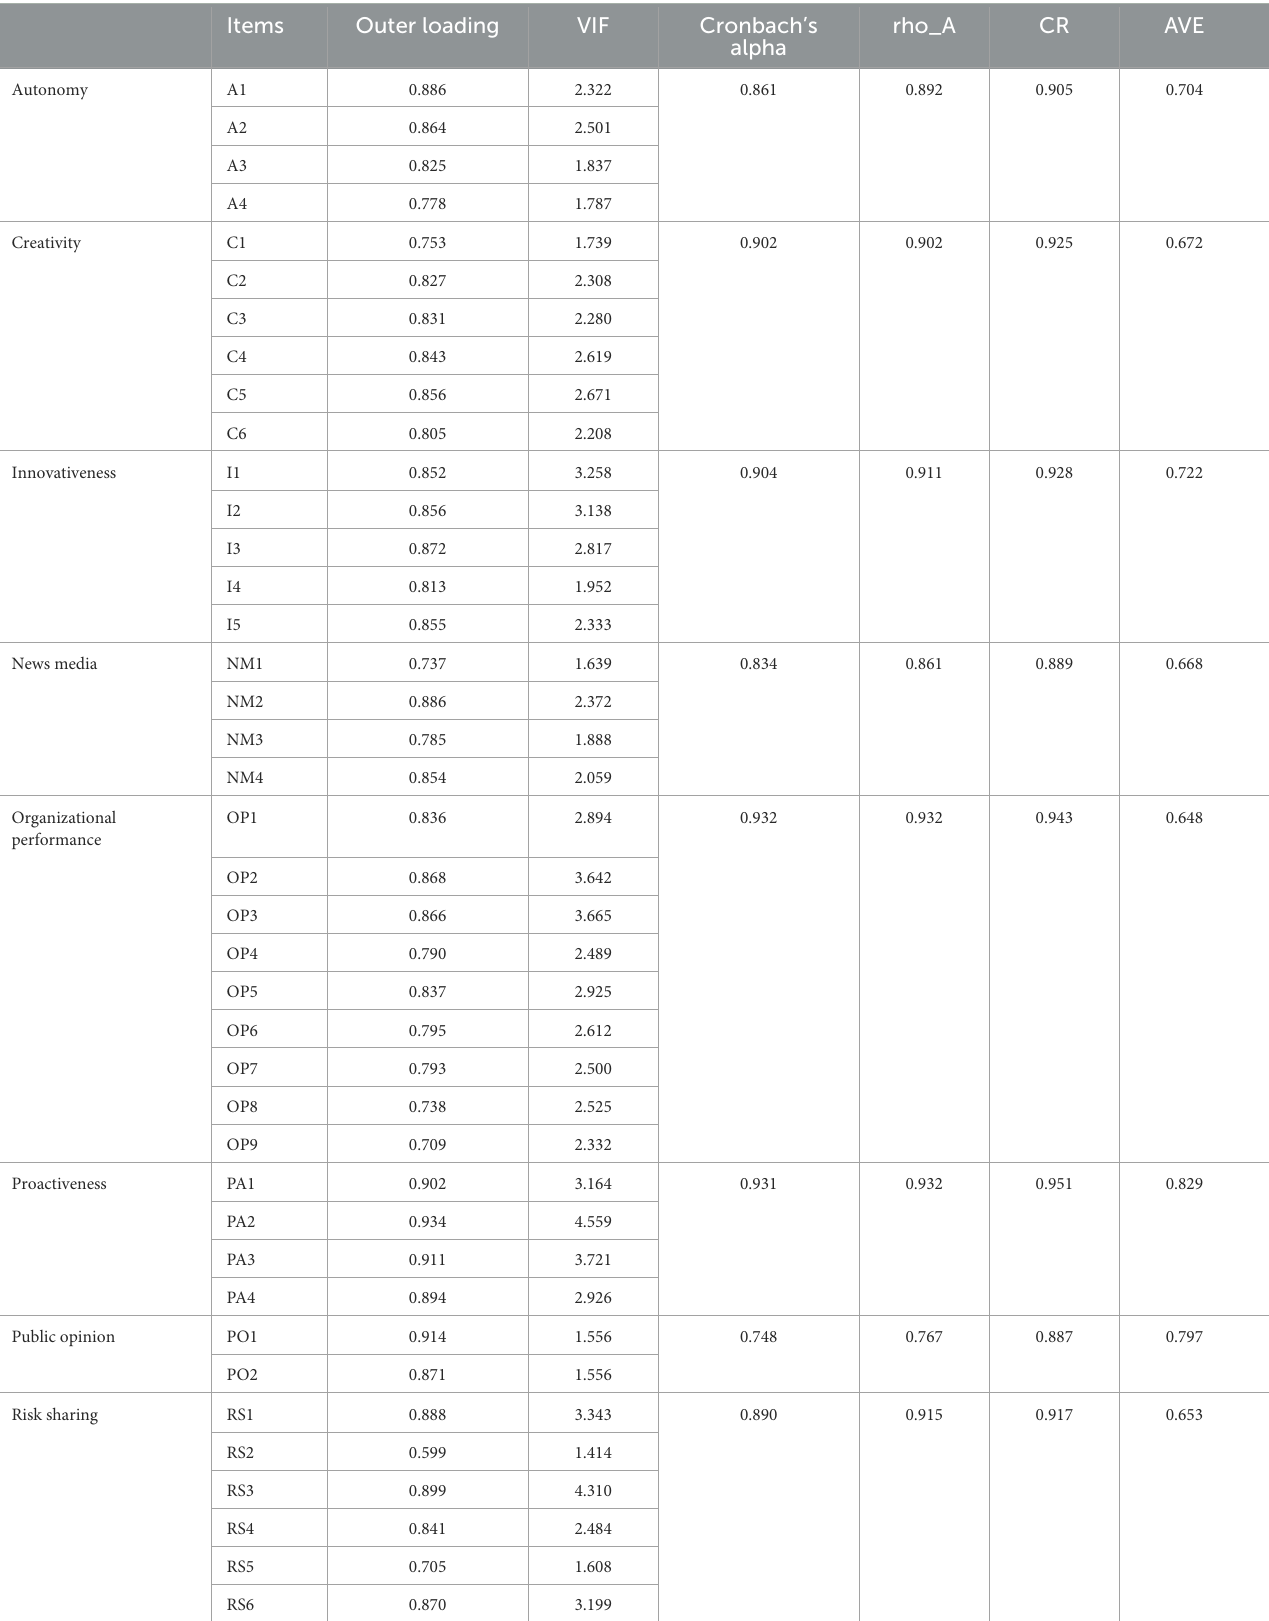
TABLE 3 Construct reliability and